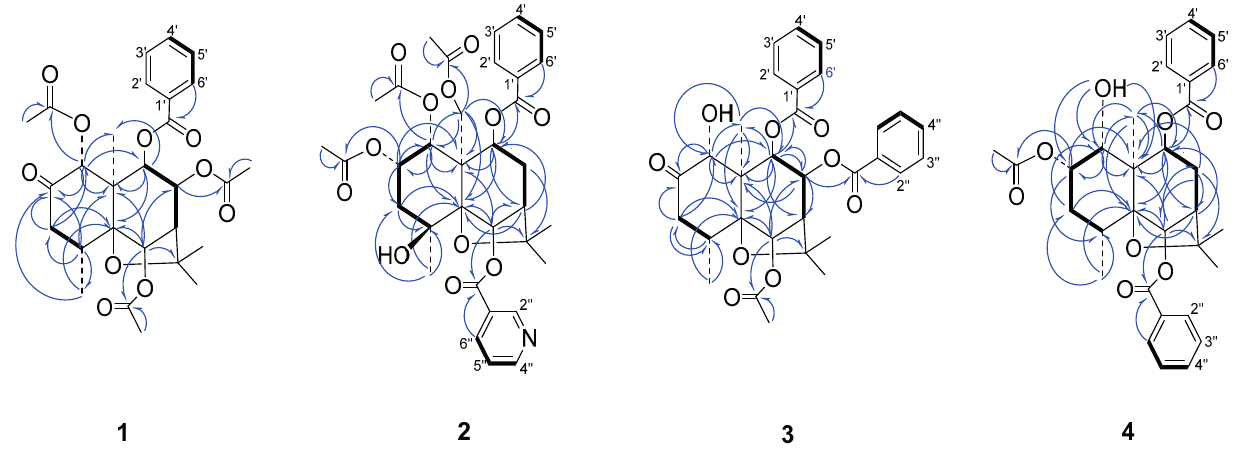
Figure 2. Main 1 H- 13 C long-range correlation ( ) and 1 H- 1 H correlation ( — ) signals in the HMBC (Heteronuclear Multiple Bond Correlation) and COSY ( 1 H- 1 H Correlation Spectroscopy) spectra of 1 – 4 .